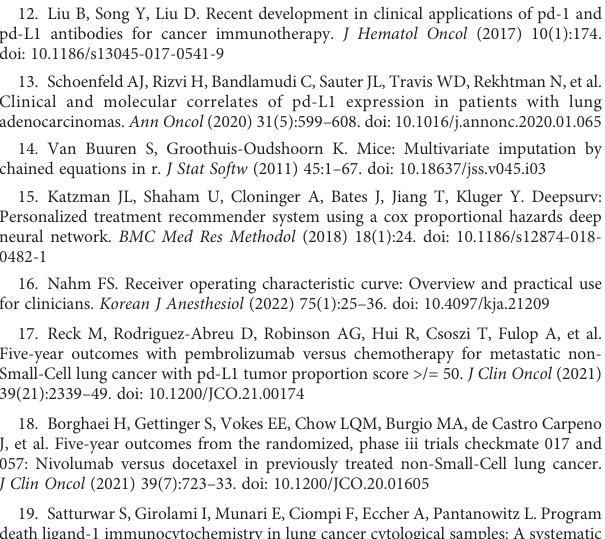
SUPPLEMENTARY FIGURE 1 The distribution of missing values. ECOG PS score, Eastern Cooperative Oncology Group performance status score. PD-L1, programmed cell death ligand 1. BOR, best of response. PFS, progression free survival. OS, overall survival. SUPPLEMENTARY FIGURE 2 Risk factors and protective factors on overall survival in III-IV stage lung adenocarcinoma patients after immunotherapy. PS score, performance status score. PD-L1, programmed death-ligand 1. Other mutation, TP53. Uncommon mutation, ALK, ROS1, RET, MET, BRAF, HER2. Immu, immunotherapy. Antiangio, antiangiogenic. Chemo, chemotherapy. BOR, best of response. PD, progressive disease. PR, partial response. SD, stable disease. *P<0.05, **P<0.01, ***P<0.001. SUPPLEMENT FILE 1 The installation program of immunotherapy ef fi cacy predictive tool. SUPPLEMENT FILE 2 The raw clinical